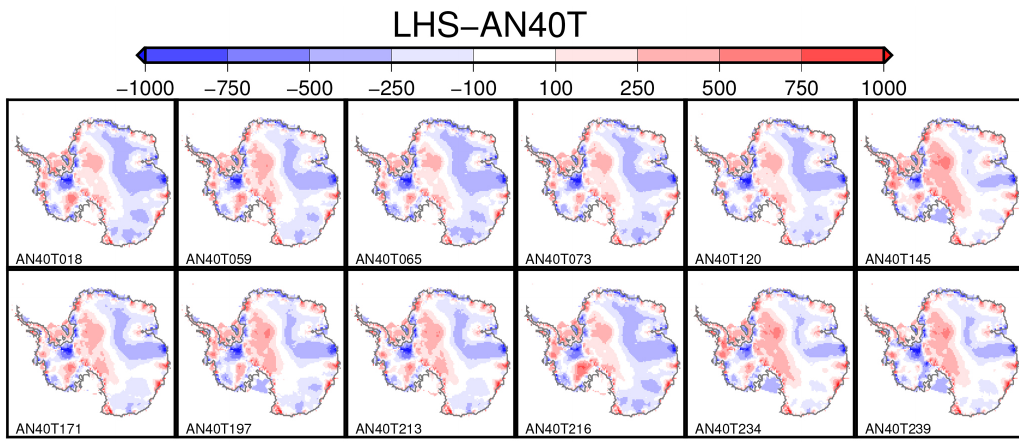
Figure 8. Same as Fig. 7 but with the Tsai et al. (2015) formulation of the flux at the grounding line (AN40T).